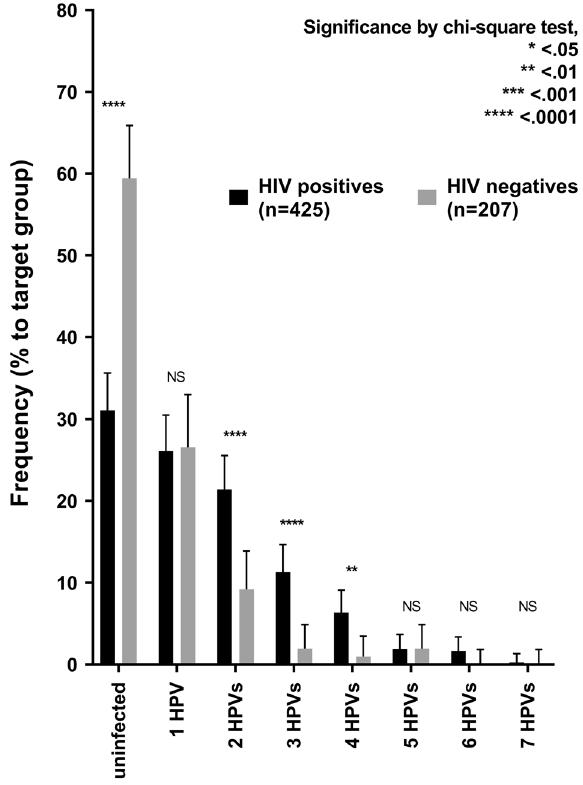
Figure 2. Number of hr-HPV genotypes in HIV-infected and -uninfected MSM. The frequency of hr-HPV genotypes identified between HIV-infected and -uninfected subjects was compared. HPV human papillomavirus, hr-HPV high-risk types of human